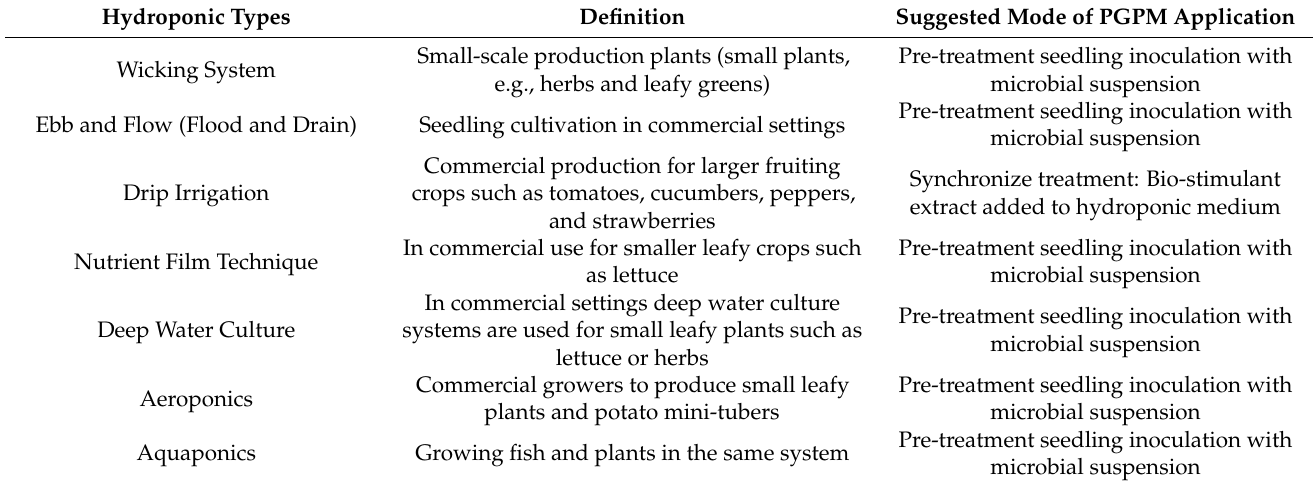
Table 2. Types of hydroponic systems and suggested mode of PGPM